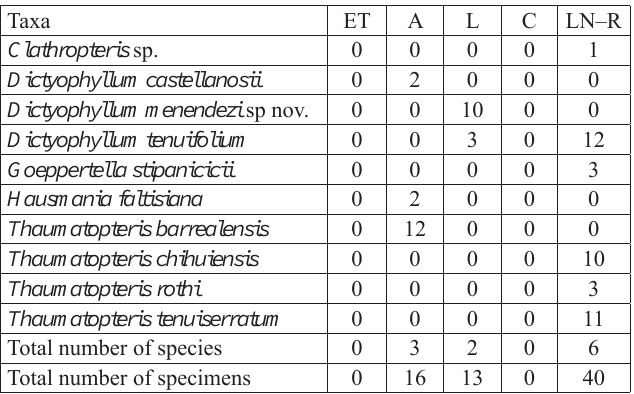
Table 5. Chronological distribution of Triassic species of Dipteridaceae from Argentina. The number of recorded specimens of each species is indicated in rows. Abbreviations: ET, Early Triassic; A, Anisian; L, Ladinian; C, Carnian; LN–R, Late Norian–Rhaetian.